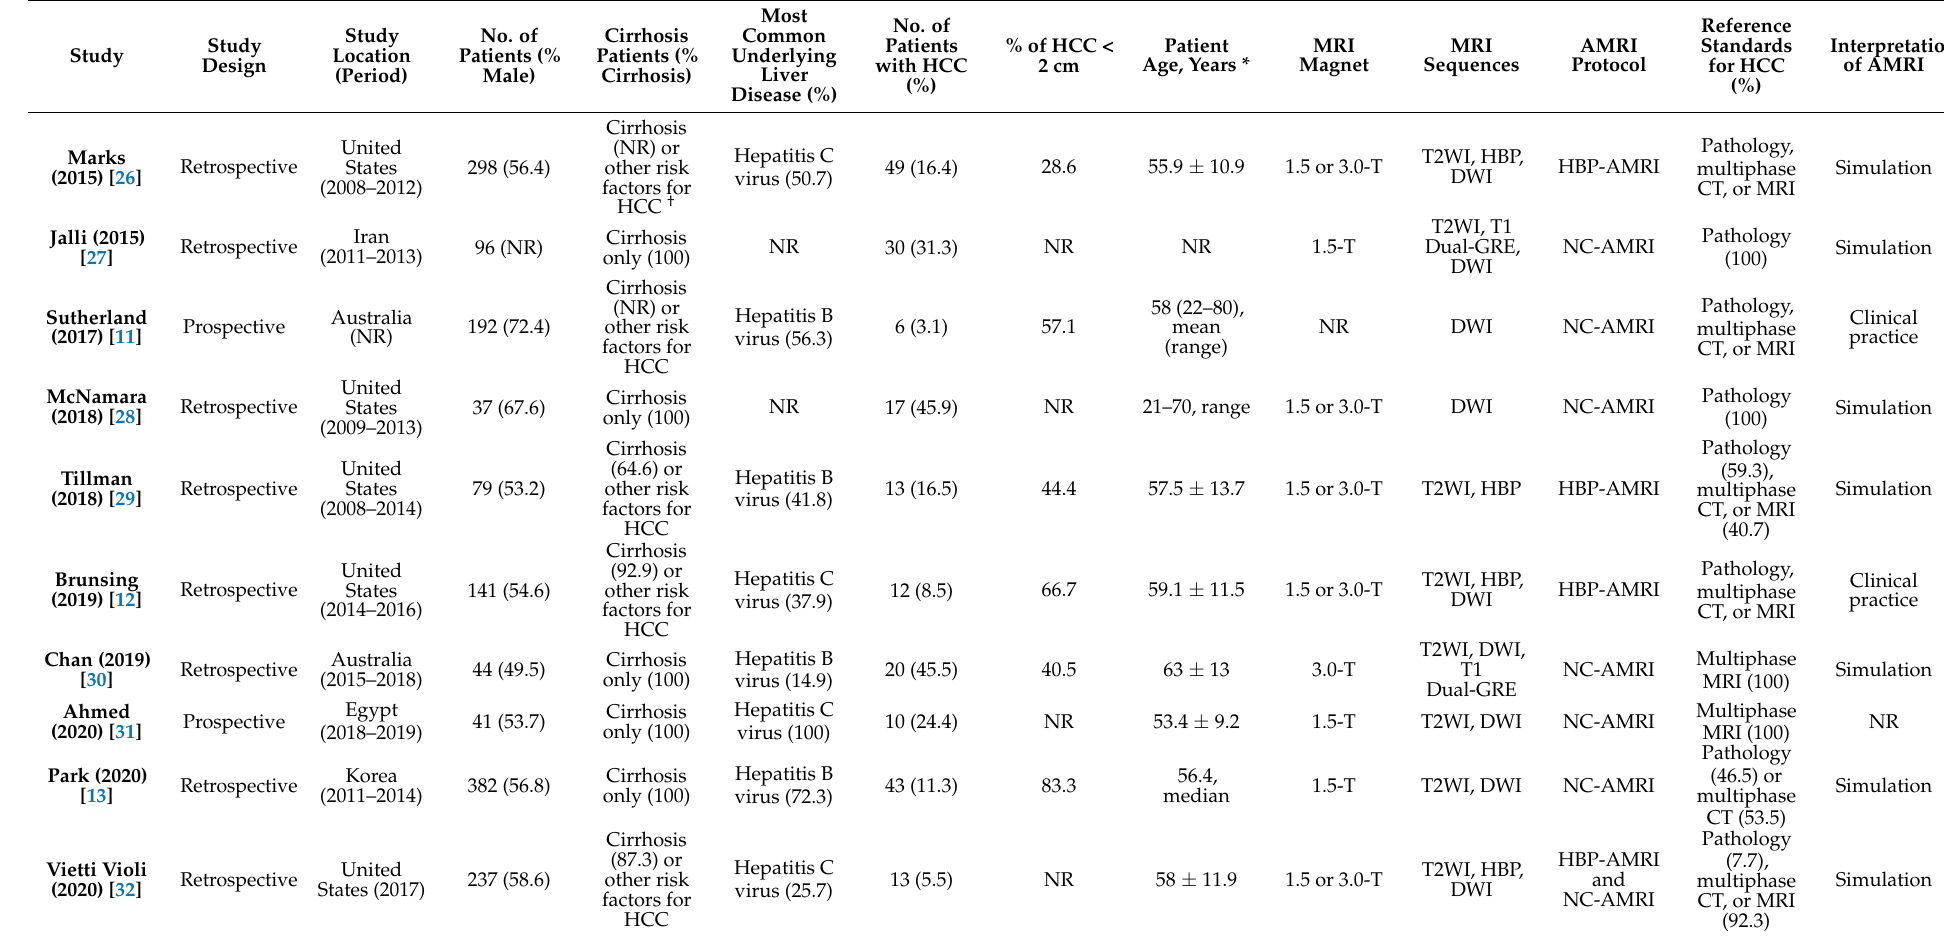
Table 1. Study characteristics of the 10 included